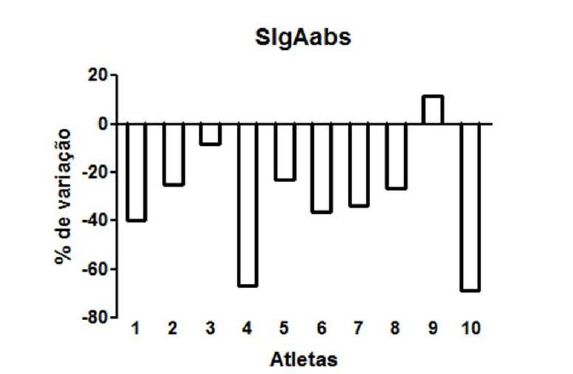
Figura 1. Percentual de variação individual da concentração de imunoglobulina salivar A entre os momentos pré e pós-simulação.